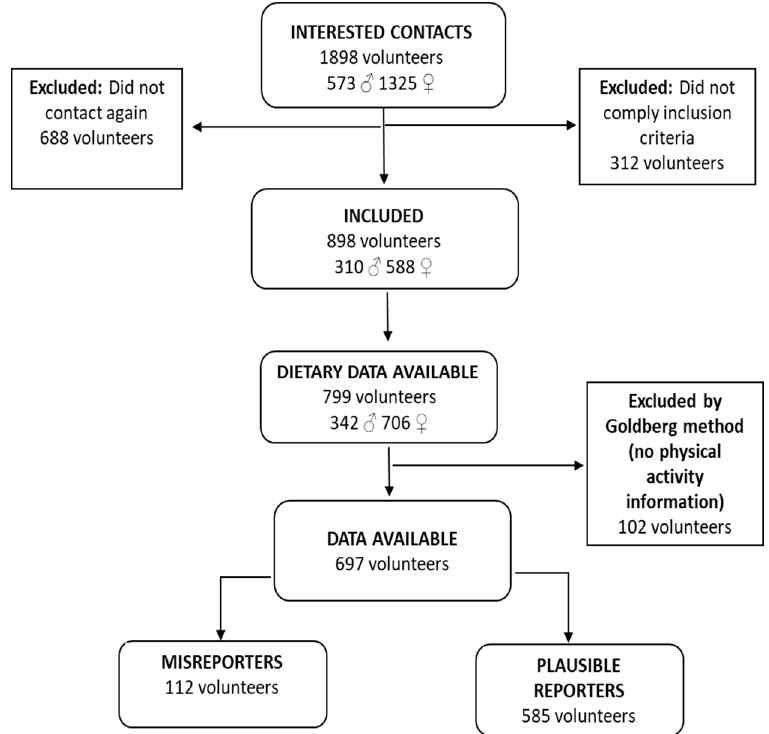
Figure A1. Study’s flow chart.